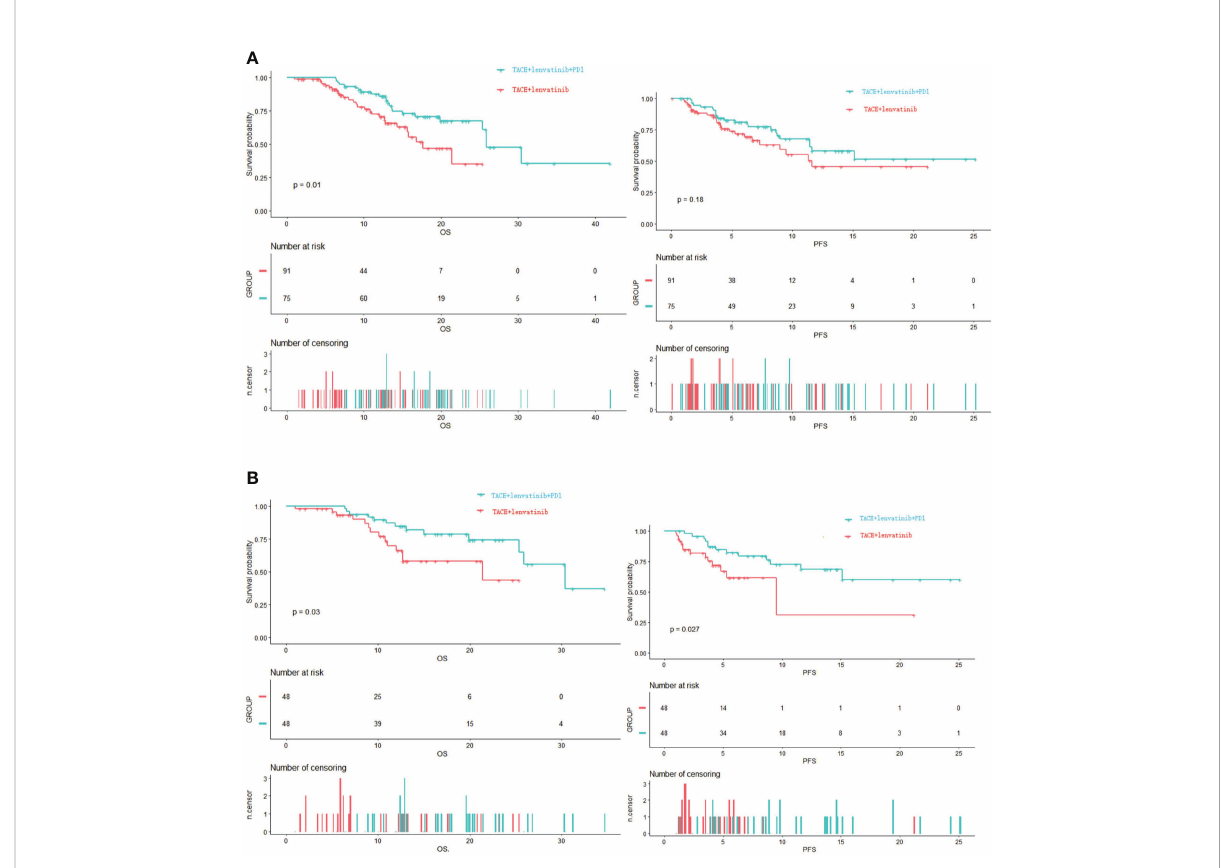
FIGURE 2 (A) Kapan – Meier curves of OS and PFS before PSM. (B) Kapan – Meier curves of OS and PFS after PSM. OS, overall survival; PFS, progression-free survival; PSM, propensity score